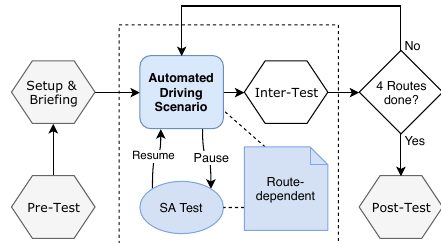
Figure 6. The study process: each participant completed the cycle of automated driving scenario and inter-test four times in a balanced scheme, thus experiencing each of the routes and main